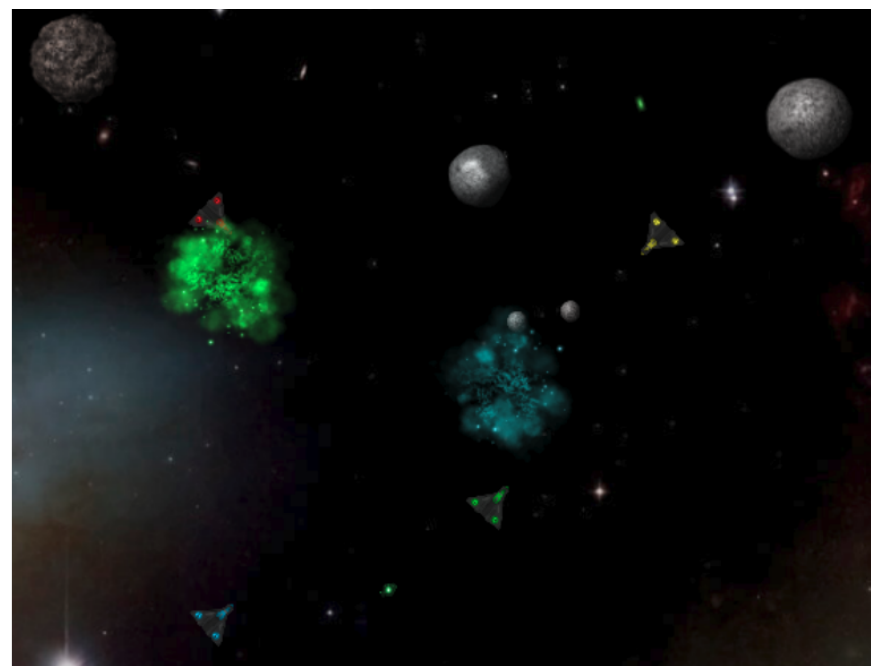
Figure 3. War of Asteroids. Screenshot of a game with four ships competing against each other.